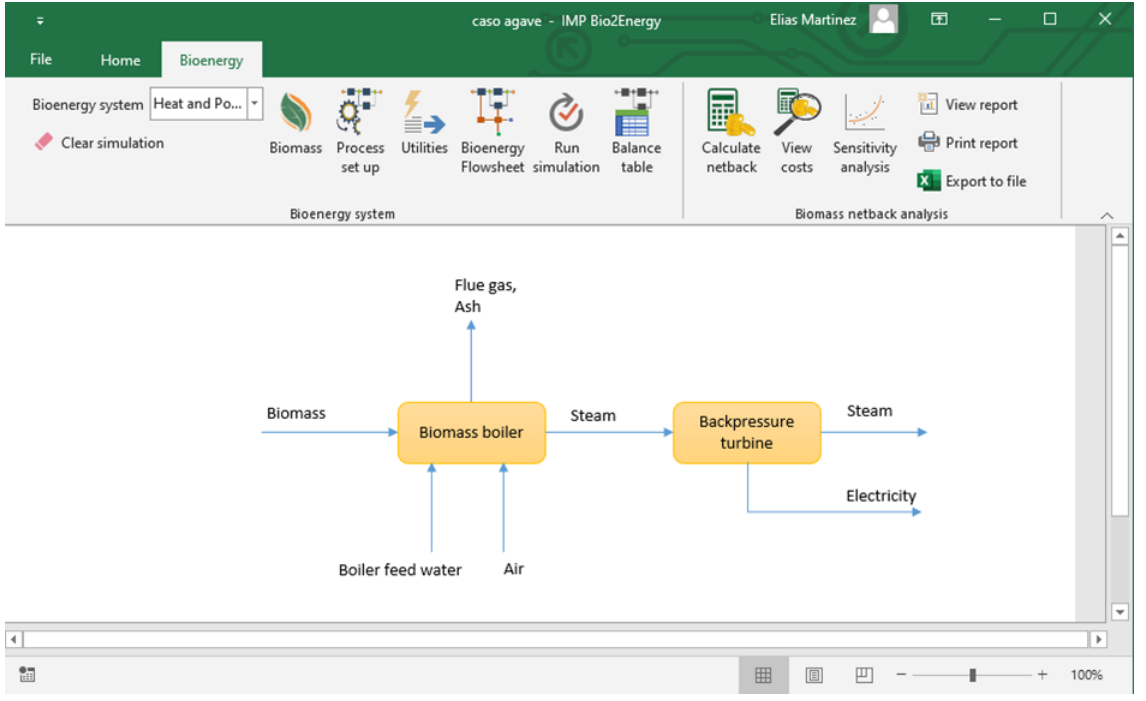
Figure 2. Screenshot of IMP Bio2Energy® software for the bioenergy module showing the flowsheet of the general CHP system simulated.